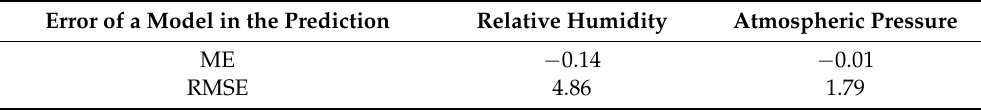
Table 2. Table of average errors in the model from 2010 to 2021; ME, mean error; RMSE, root mean square